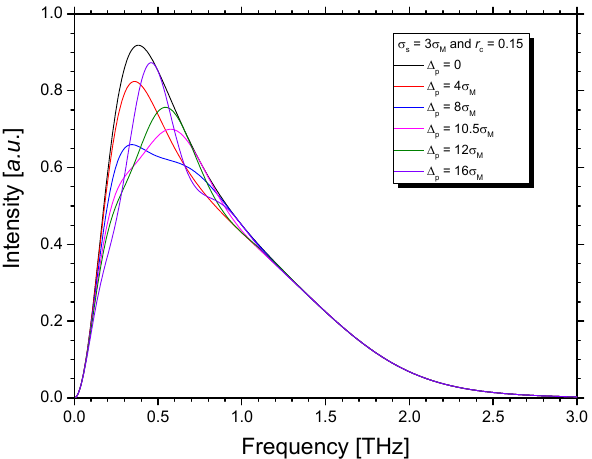
Figure 9. Calculated CER spectra for several ∆ p with σ S = 3 σ M and r c = 0.15.